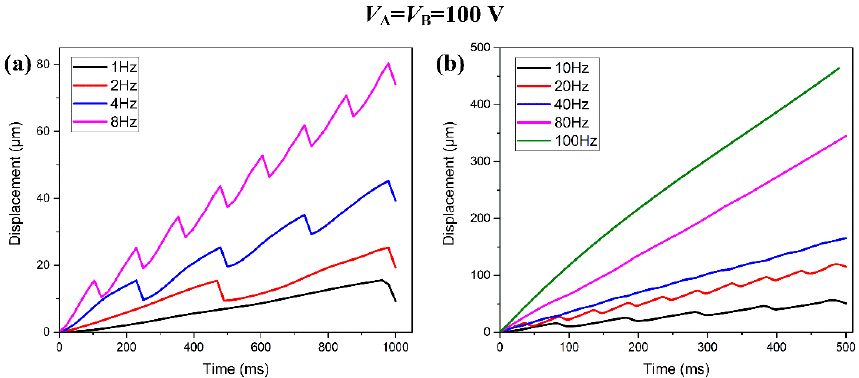
Figure 11. Motion displacement under different driving frequencies: ( a ) 1–8 Hz; and ( b ) 10–100 Hz.